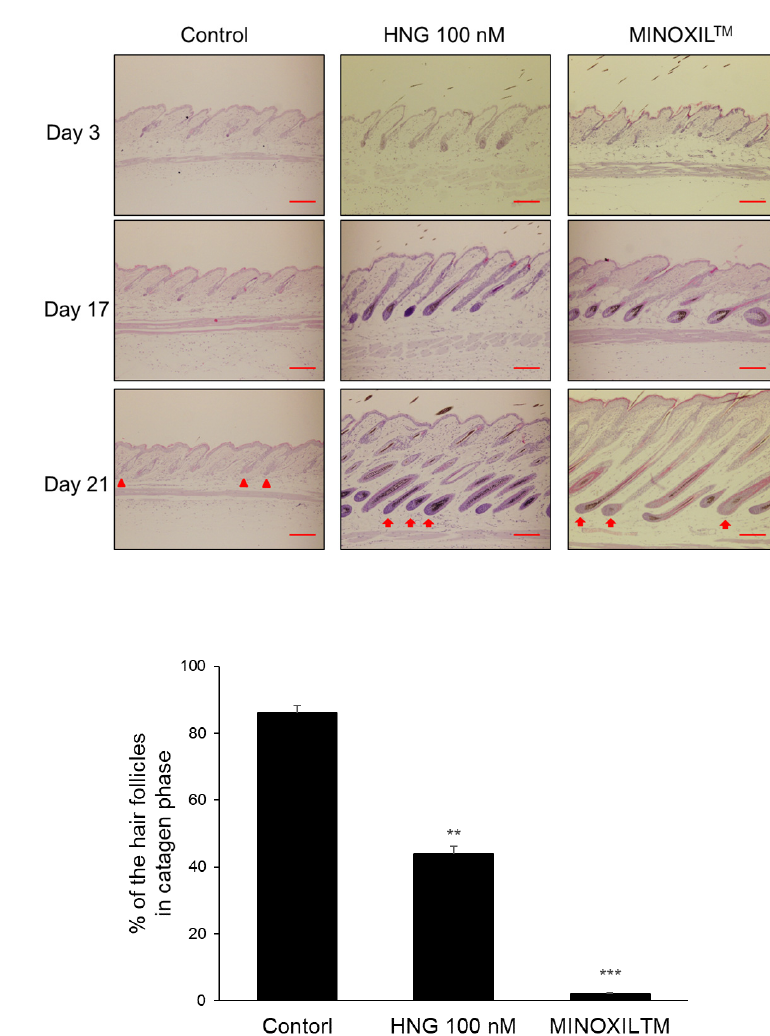
Figure 3. HNG stimulates the duration of the anagen phase in vivo model. After depilation, the dorsal skin of the mice was topically treated with vehicle, HNG, and MINOXIL ™ once a day for 35 days. ( A ) The dorsal skin of C57BL / 6 mice was photographed from day 0 to the 35th day on every 7th day after depilation. ( B ) Quantified hair growth in control, HNG 50, 100, 200 nM, and MINOXIL ™ groups on the 35th day using dot matrix planimetry. ( C ) Colorimetric Tdt-mediated dUTP-Dig nick and labeling (TUNEL) assay performed. Scale bars represent 100 µ m, but 200 µ m in smaller figures. ( D ) Quantitative analysis of TUNEL-positive cells on the 21st day in ( C ). Mean values ± S.D. *** p < 0.001 vs. control. At least 10 hair follicles were examined. ( E ) Hematoxylin and eosin staining. Scale bars represent: 100 µ m; anagen hair follicle indicated by arrow; catagen hair follicle indicated by arrowhead. ( F ) Quantification (%) of catagen hair follicle in ( E ) using histomorphometry. Hair follicles ( n ≥ 100) on the 21st day were examined. Mean values ± S.D. ** p < 0.01 vs. control, *** p < 0.001 vs. control .